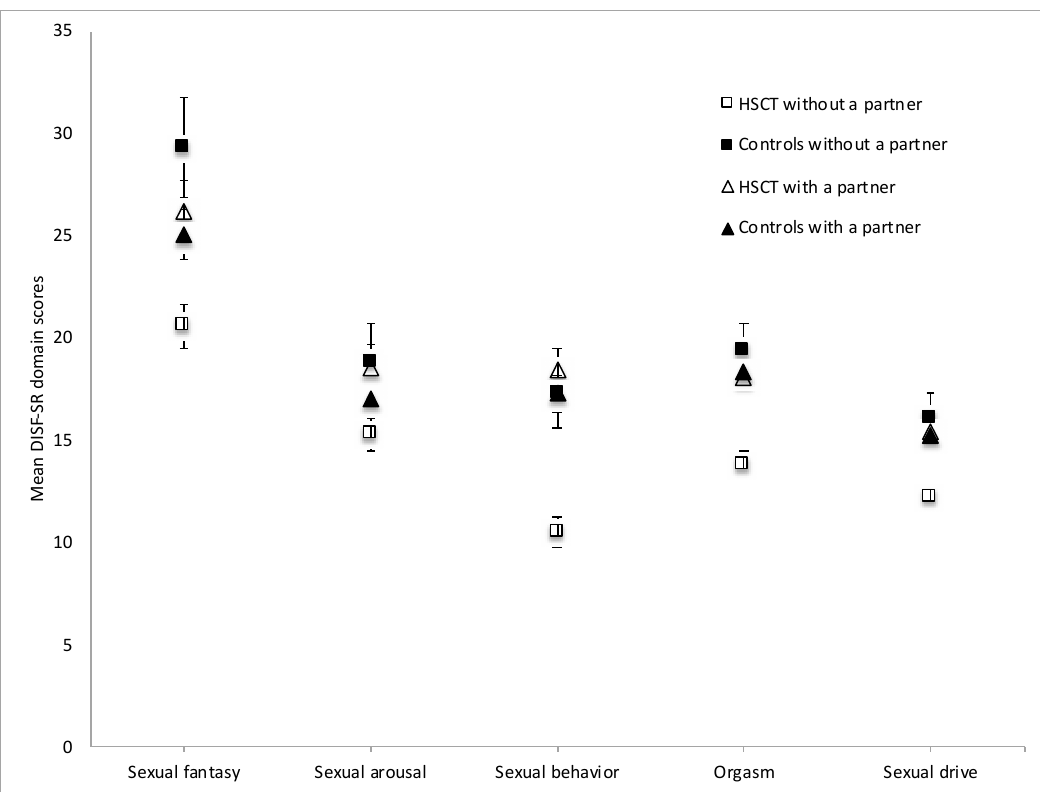
Figure 1. Mean scores on the Derogatis Interview for Sexual Functioning self-report (DISF-SR) in HSCT survivors and their controls categorized by partner status.